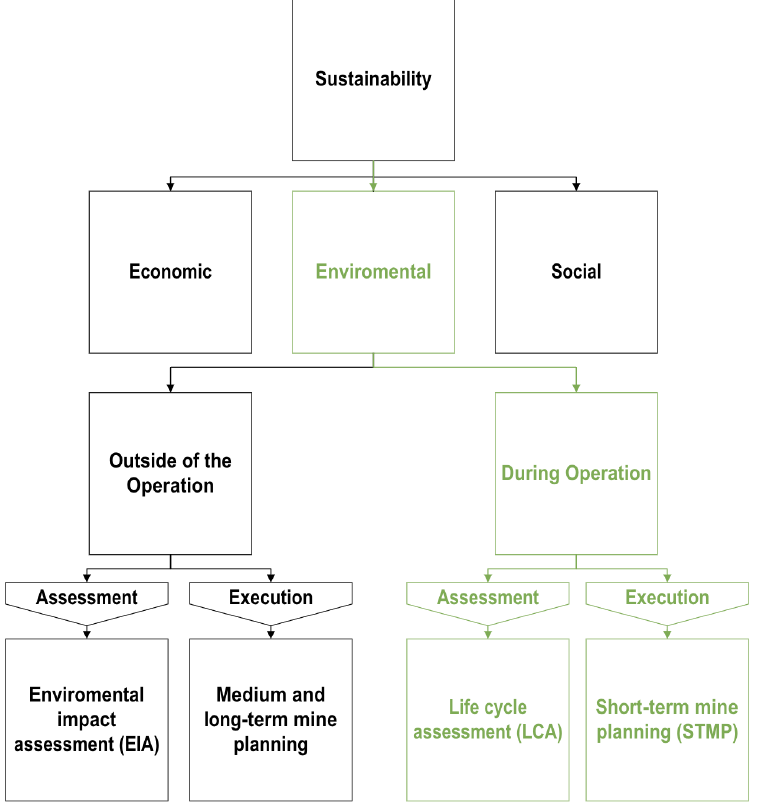
Figure 1. Environmental impacts and mine planning: a hierarchical